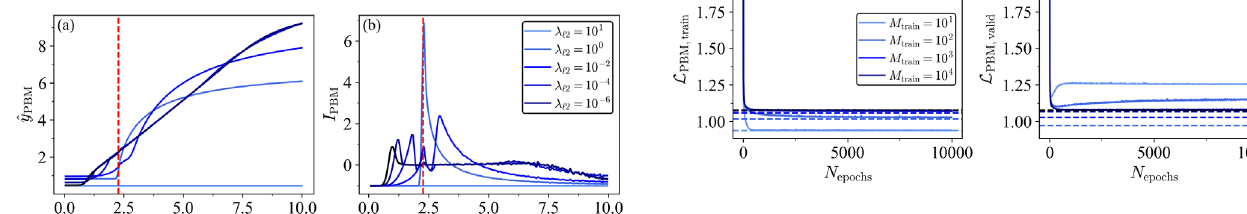
per train M M = 5 . The corre- valid ¼ test ¼ train